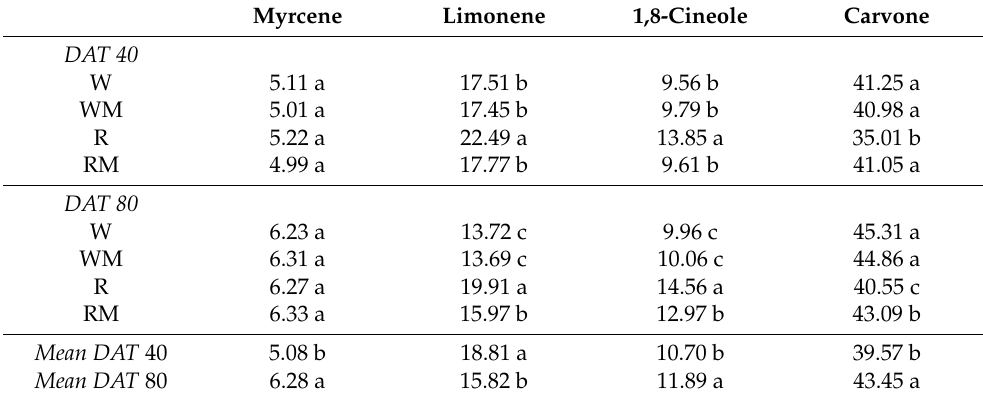
Different letters in columns indicate significant differences among treatments in the given DAT at p ≤ 0.05. Data related to Mean DAT 40 and Mean DAT 80 are means for all treatments and different letters in columns indicate significant differences between 40 and 80 DAT at p ≤